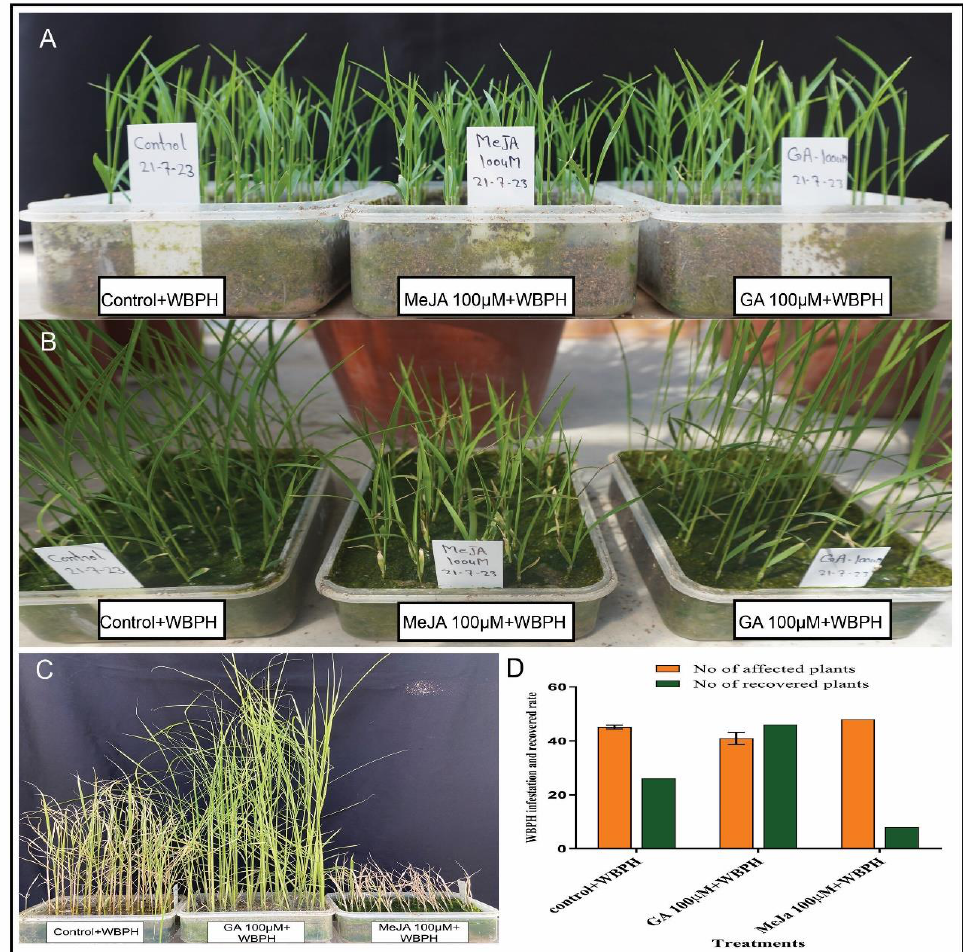
Figure 5. The recovery rate of WBPH-affected plants by exogenous GA and MeJA hormones. ( A ) The plants before WBPH infestation and hormone treatment. ( B ) After 7 days of WBPH stress and continuous treatment with 100 µM GA and 100 µM MeJA. ( C ) Recovery of plants after 7 days. ( D ) Graphical representation of affected and recovered plants after WBPH stress by applying exogenous hormones. Error bars represent the standard error of the mean data ( n = 3). Table 1. The number of insect counts per day in different treatment groups.